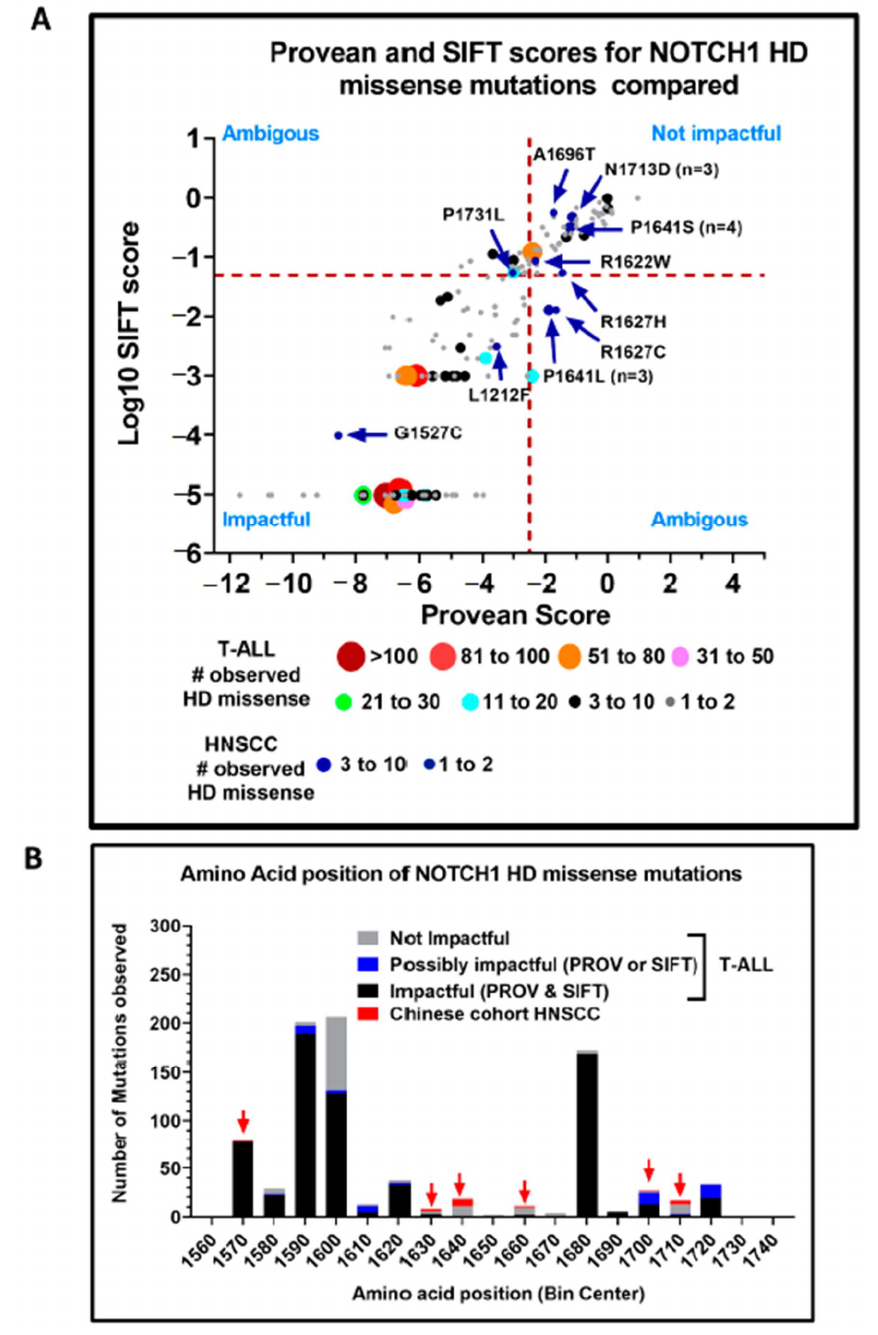
Figure 5. Comparison of potentially activating NOTCH1 mutations reported from the HD domain from two Chinese HNSCC cohorts [16,17] and T-ALL from the COSMIC database. ( A ) The PROVEAN and SIFT scores for each mutation. For T-ALL, the total numbers of mutations in each region of the graph are indicated by both color and circle size, with increasing diameters signifying increasing numbers of mutations. Mutations observed in HNSCC studies are indicated with blue circles. Mutations in the lower left quadrant with the lowest PROVEAN and SIFT scores are predicted to be the most impactful, while mutations in the upper right quadrant are predicted to be the least impactful. ( B ) Distribution of NOTCH1 HD domain mutations. Colored bars indicate whether T-ALL mutations are predicted to be impactful by both PROVEAN and SIFT, possibly impactful (i.e., PROVEAN or SIFT), or not impactful by both methods. For comparison, HNSCC NOTCH1 mutations are represented by the red boxes and bins where HNSCC mutations occur are also indicated with red